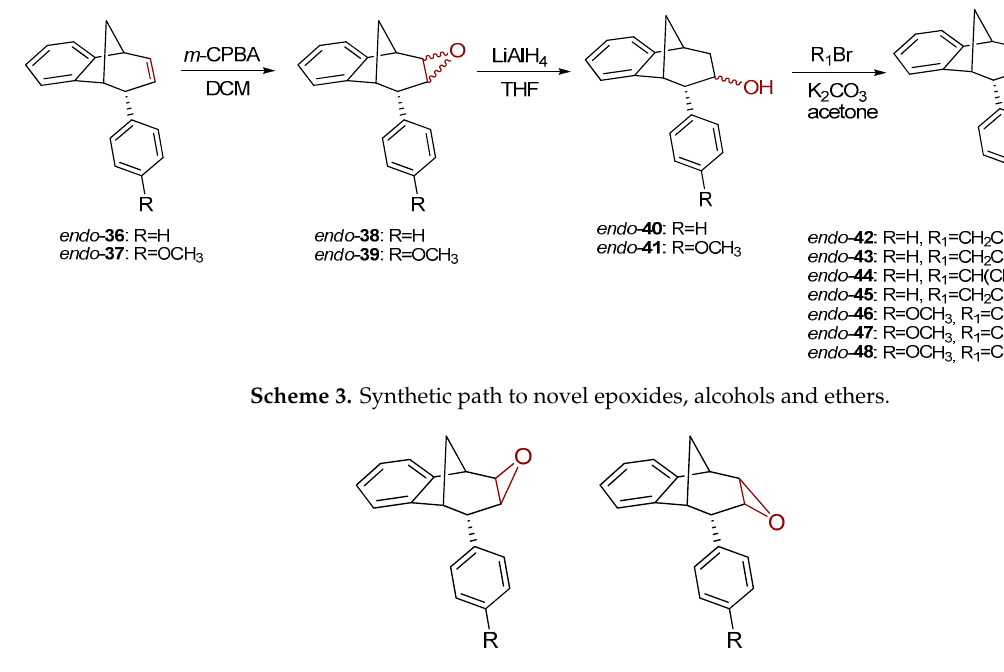
Figure 5. Representation of the stereoisomers of the obtained epoxides endo - 38 (R = H) and endo - 39 (R = OCH 3